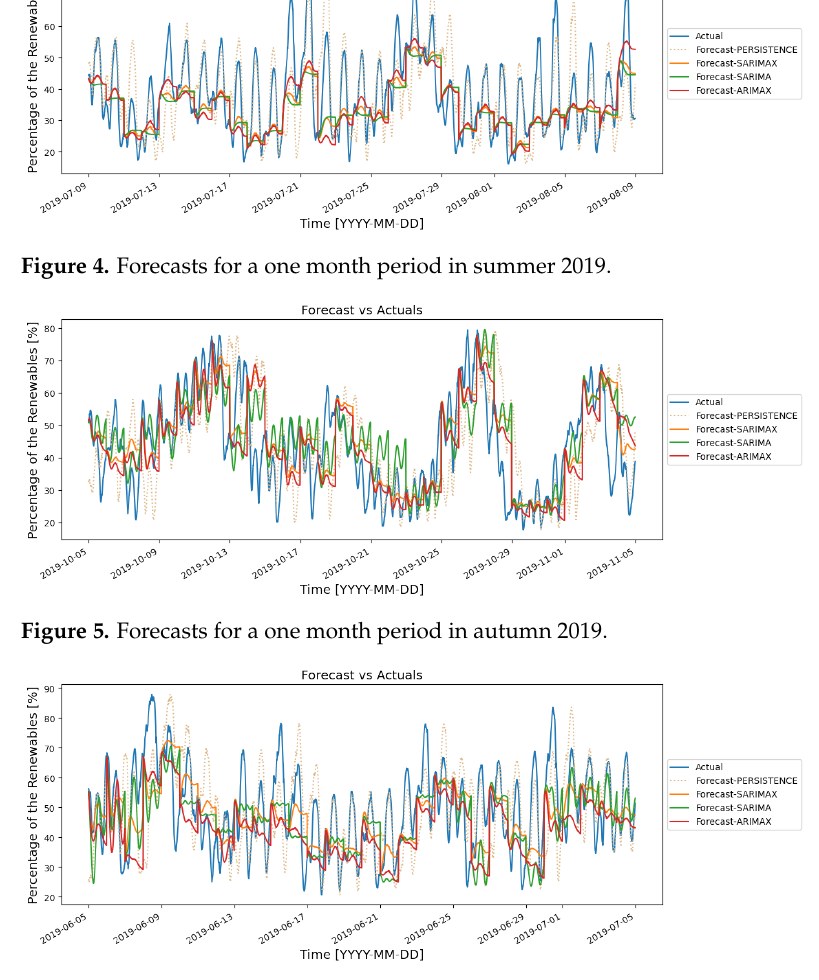
Figure 6. Forecasts for a one month period between late spring and early summer